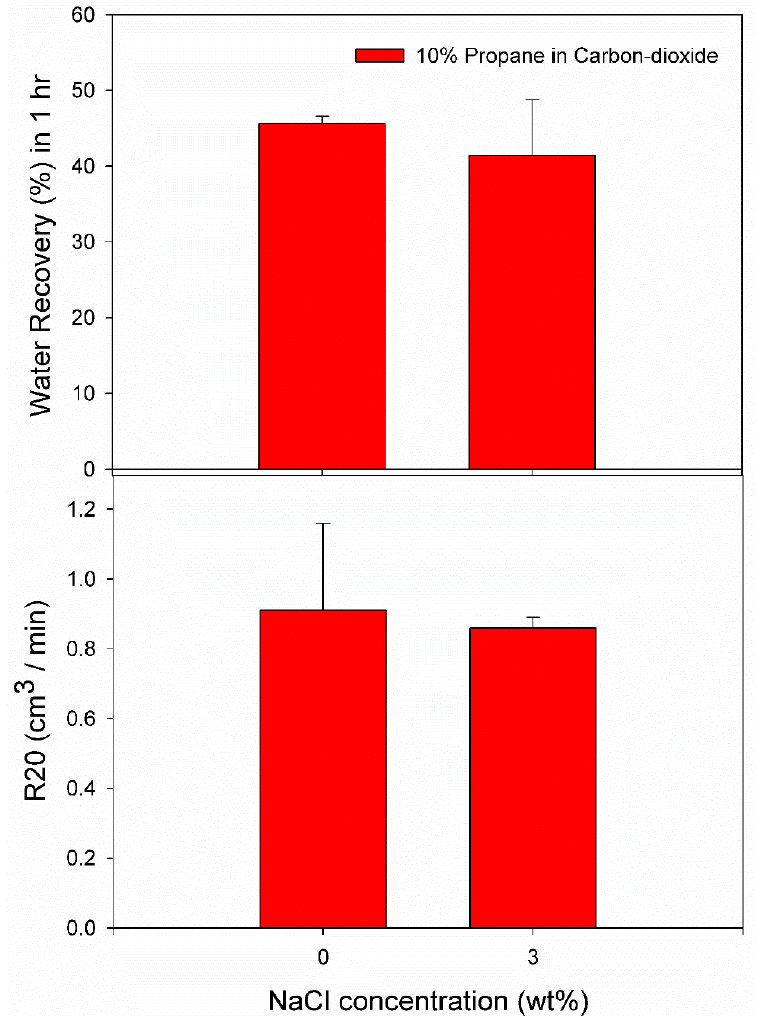
Figure 8. Effect of NaCl concentration on water recovery for 10% propane in carbon dioxide.